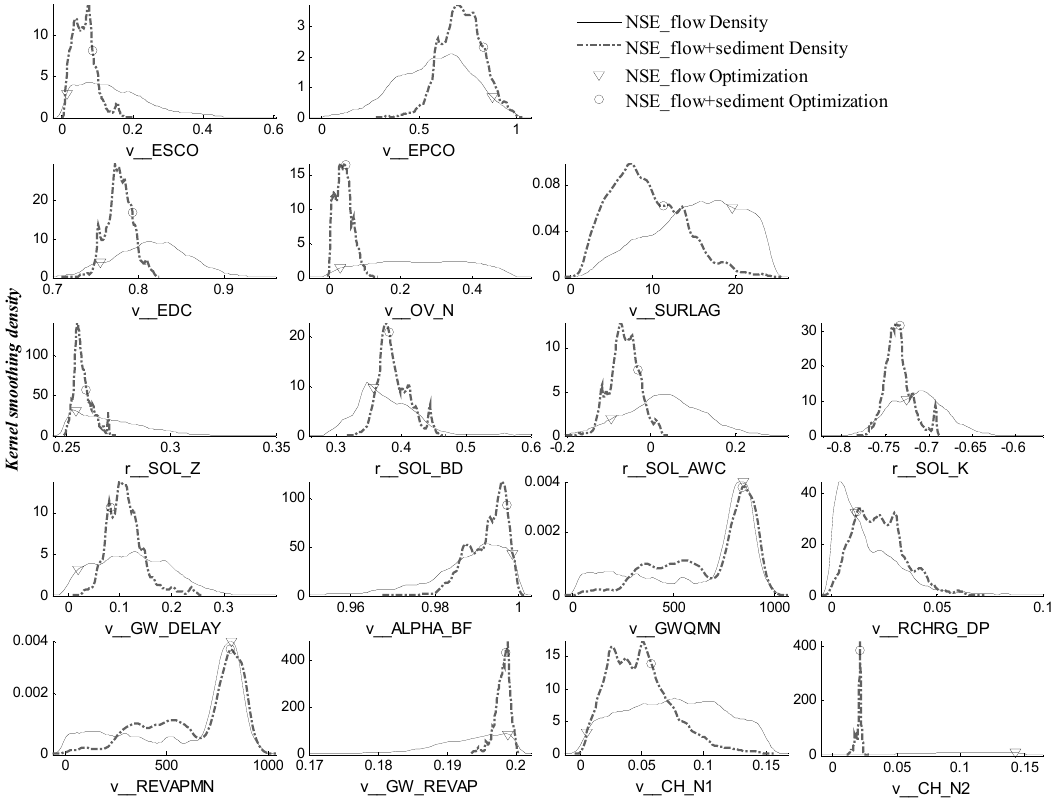
Figure 5. Comparison of the posterior distribution and optimal value (point) of flow parameters estimated by the multi- (dash line) and single-objective (solid line) NSE approaches.